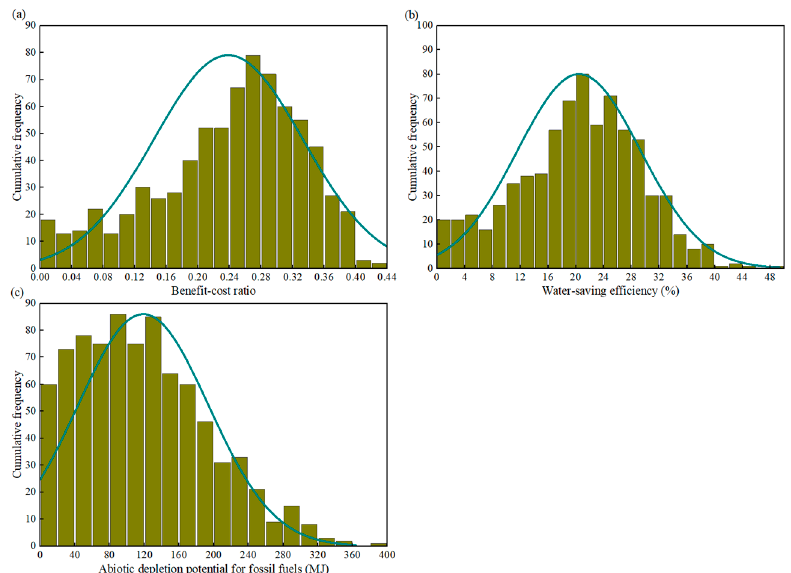
Figure 6. Simulated values histogram of: ( a ) benefit–cost ratio; ( b ) water-saving efficiency; ( c ) abiotic depletion potential for fossil fuels.